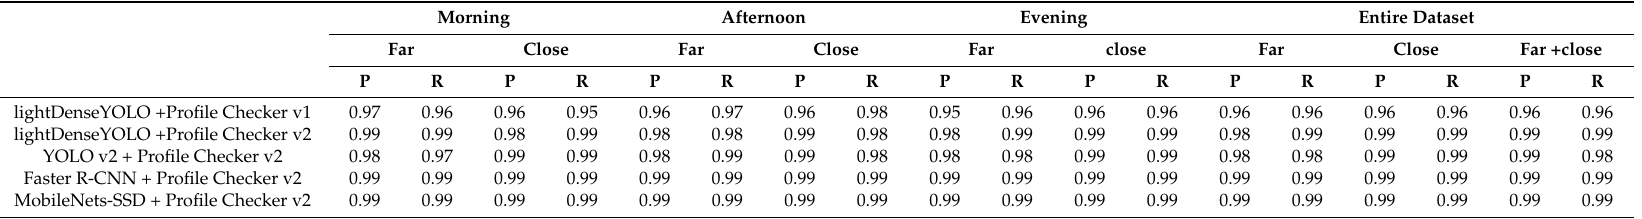
Table 8. Precision (P) and recall (R) at IoU = 0.5 of different CNN marker detectors with Profile Checker